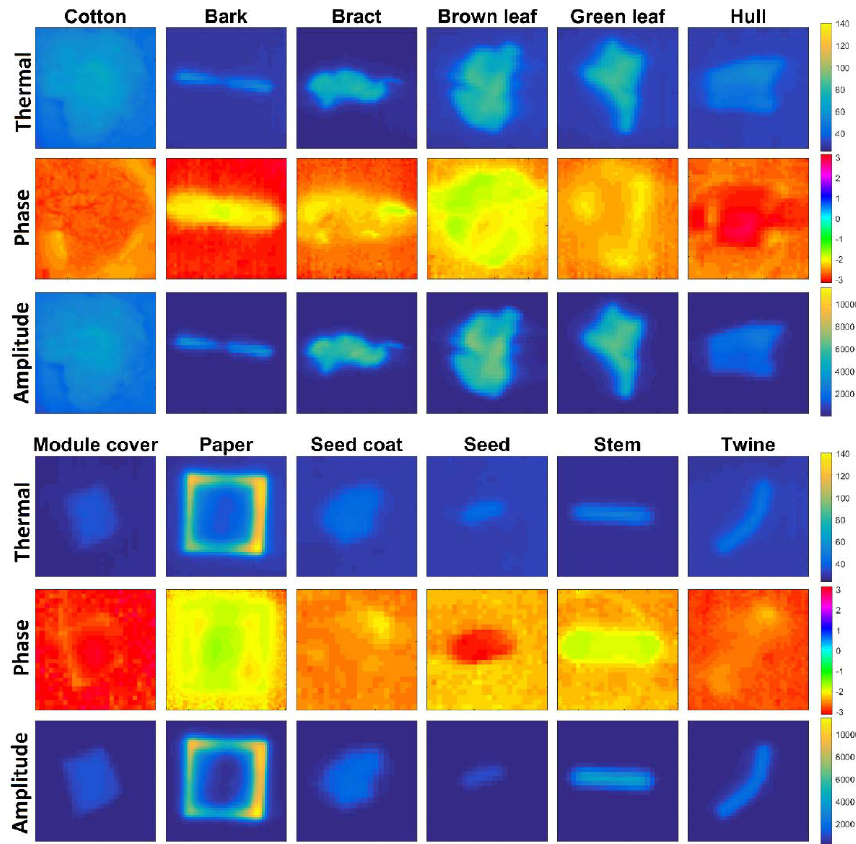
Figure 9. Thermal images, phasegrams, and ampligrams of each sample type.